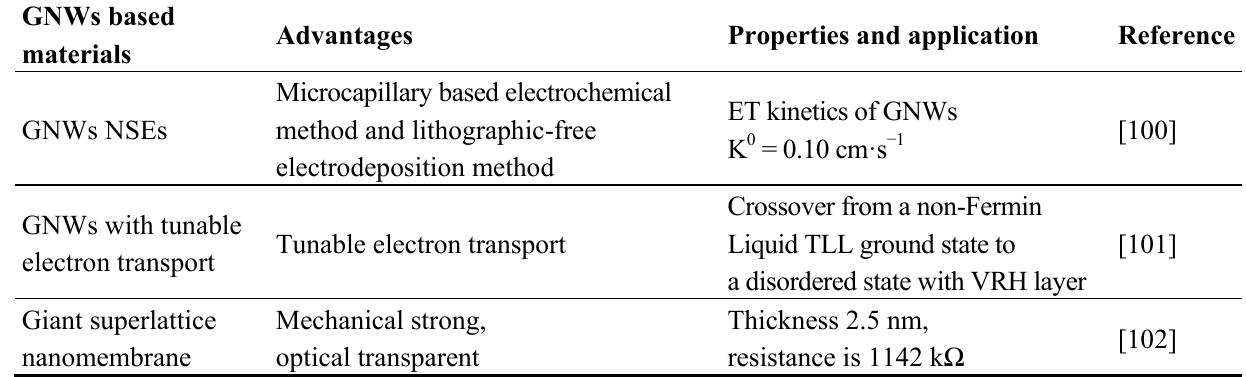
Table 6. List of GNWs based electrochemical sensing